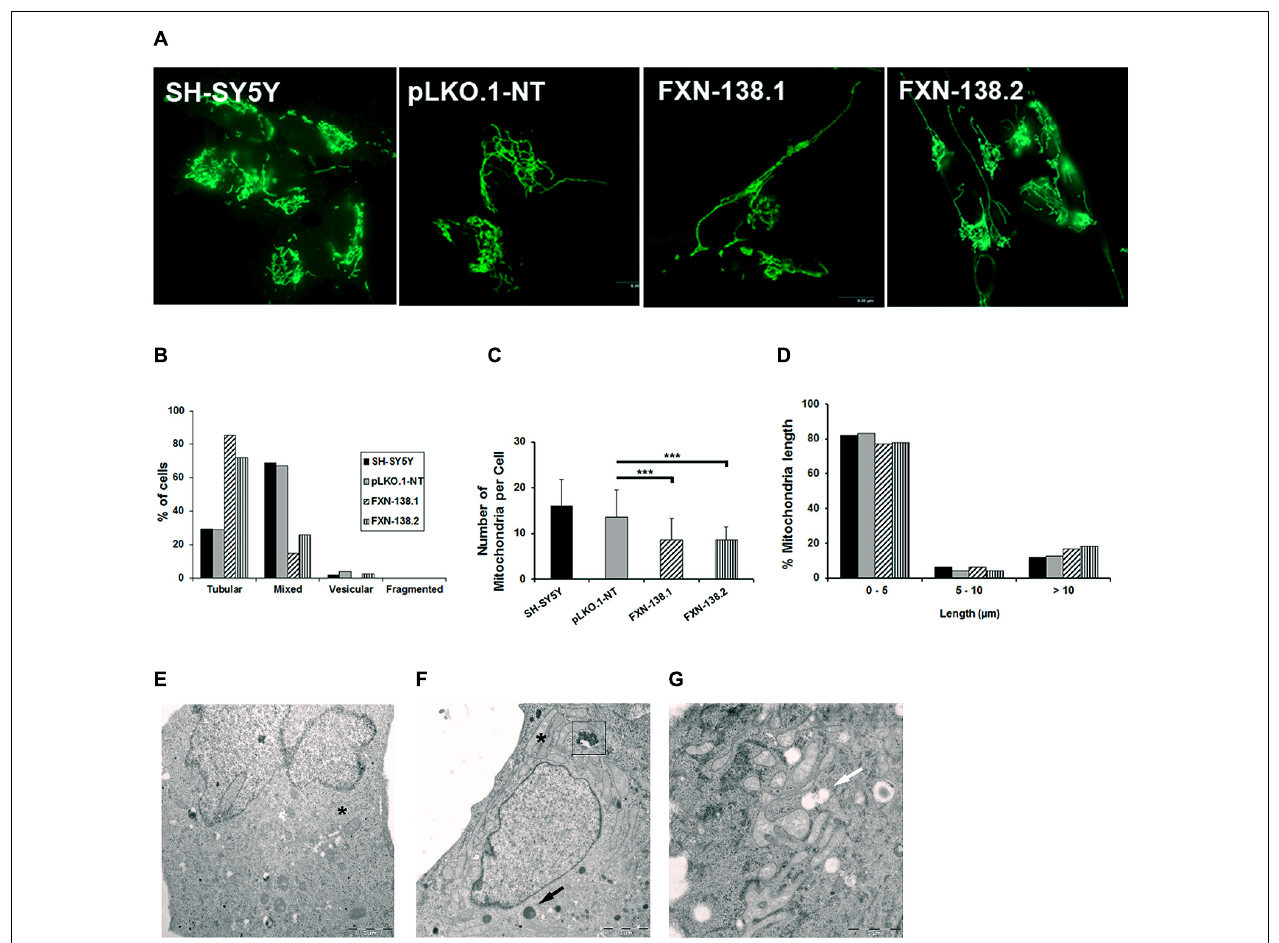
FIGURE 7 | Quantification of mitochondrial dynamic process in SH-SY5Y clones. (A) Representative mitochondrial network shows increased fusion morphology in frataxin-deficient cells. (B) Quantification of four different mitochondrial architectures within the cell: tubular, mixed (tubular and vesicular), vesicular, and fragmented. (C) Average number of mitochondria per cell in all the clones. Error bars indicate the standard deviation. Student’s t -test, FXN-138.1 p = 0.00006, FXN-138.2 p = 0.00004 versus pLKO.1-NT. (D) Mitochondrial length